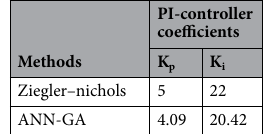
Table 3. Optimal coefficients of the